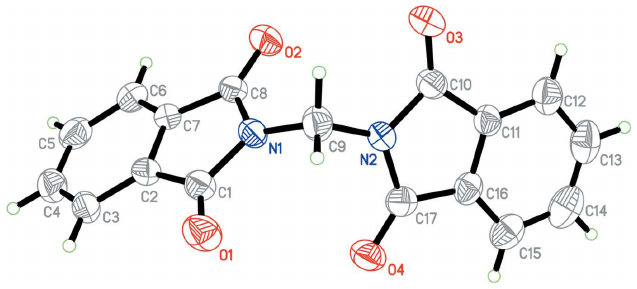
Figure 1 Molecular structure of 1 (cid:3) with atom labels and 30% probability displacement ellipsoids.